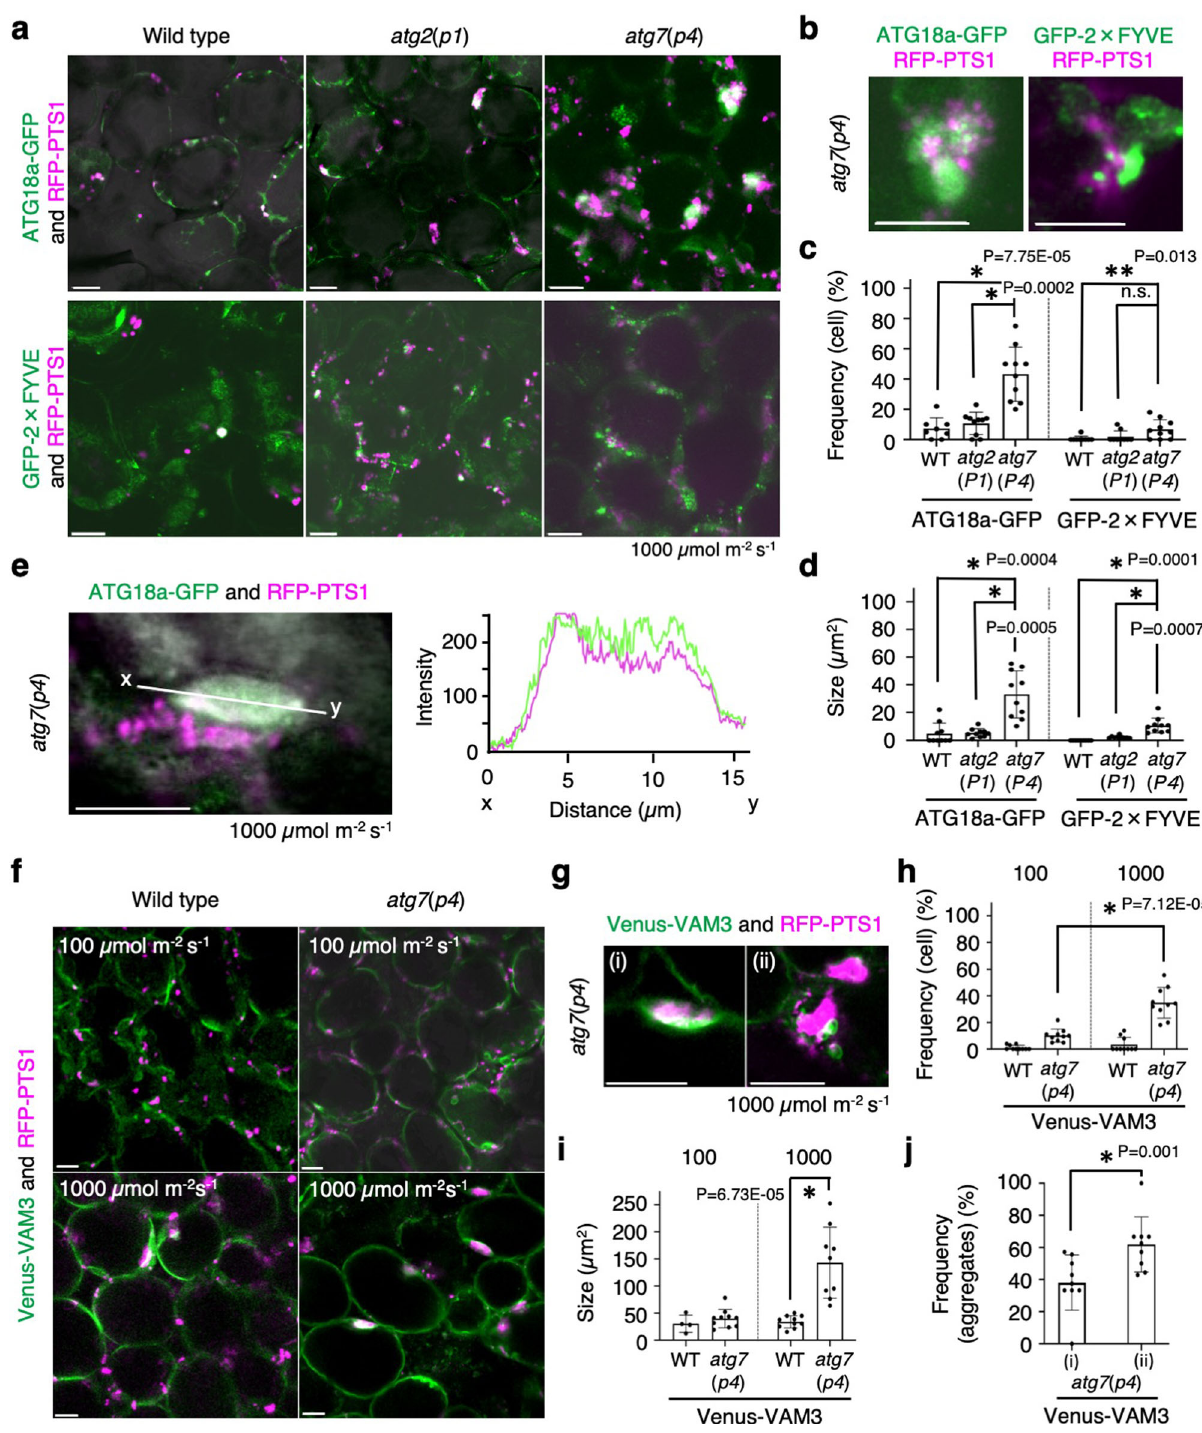
Table 6). These proteins form autophagosome-like cup and ring structures that surround peroxisomes. The peroxisome number was increased in the vacuole of ConA-treated wild-type cells in the high- intensity light compared to the low-intensity light (Supplementary Fig. 24a – c). The luminal accumulation of peroxisomal RFP-PTS1 was observed in isolated vacuoles from high-intensity light-treated wild- type cells, but not the atg7 ( p4 ) cells (Fig. 6a – f and Supplementary Figs. 24a, d, e, 27a – d, e, 28a – f, 29a – c, d). These fi ndings indicate that the light-induced peroxisome aggregates are speci fi cally degraded in the vacuole via pexophagy. The peroxisomal aggregates in atg2 ( p1